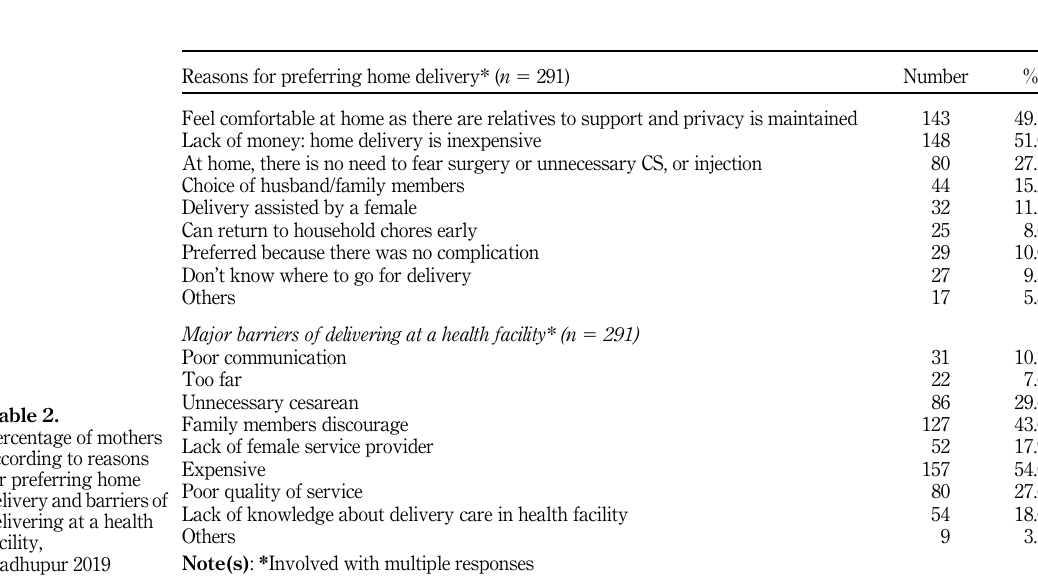
Figure 1. Distributionofmothers according to the pattern of utilization of ANC and delivery care, Madhupur 2019